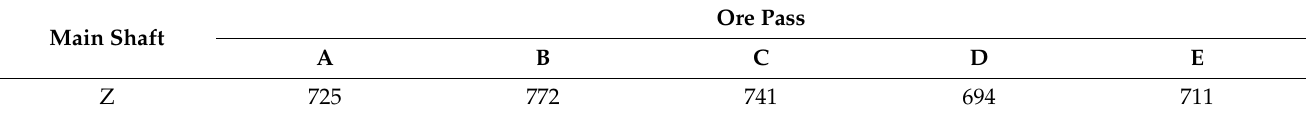
Table 7. Empty travel time of the electric locomotive between the ore pass and main shaft/s (Units: s). Main Shaft